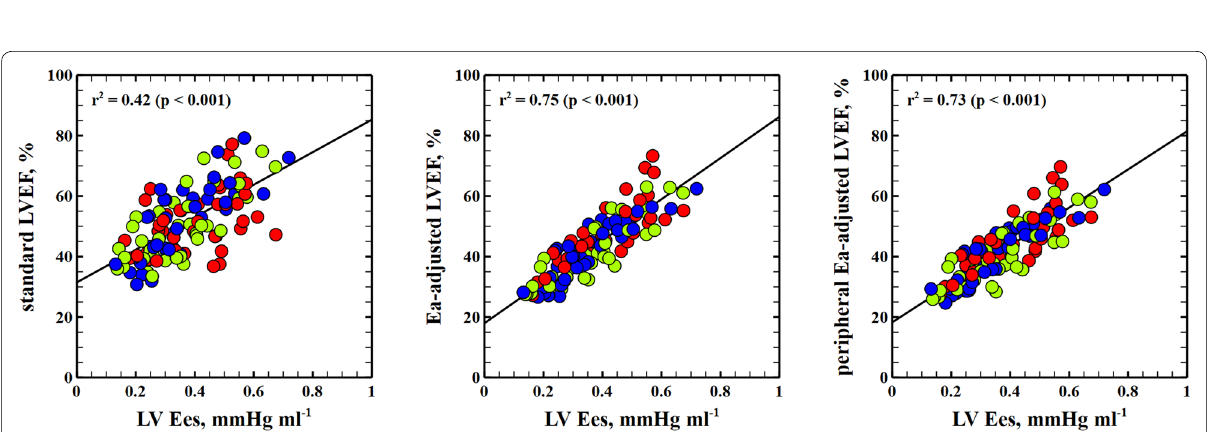
Fig. 2 Relationship between left ventricular end-systolic elastance (Ees) and standard left ventricular ejection fraction (LVEF) calculation, Ea-adjusted LVEF and peripheral Ea-adjusted LVEF. Linear regression analysis for left ventricular end-systolic elastance (Ees) and standard LVEF, LVEF corrected to effective arterial elastance (Ea left ventricular end-systolic pressure/left ventricular stroke volume) and peripheral Ea-adjusted LVEF = (Ea periph radial mean arterial pressure/stroke volume). Colors inside circles represent different interventions: red, afterload; green: preload; blue: =